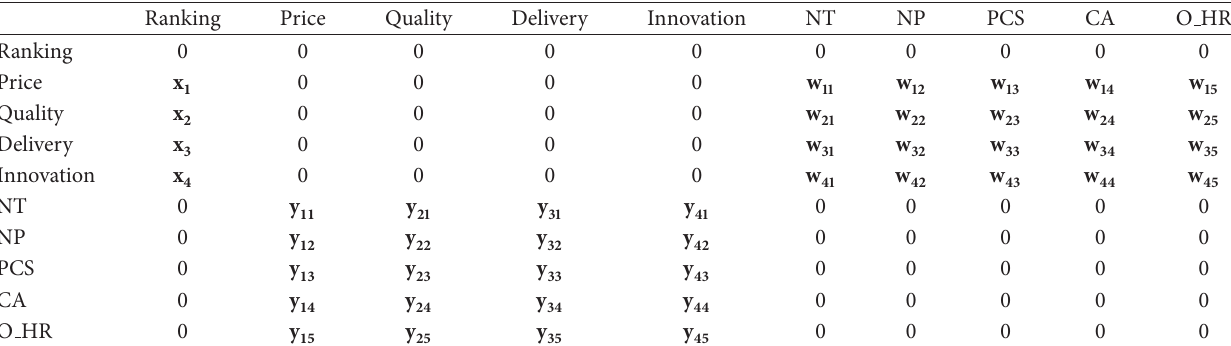
Table 2: Supermatrix of the applied example.